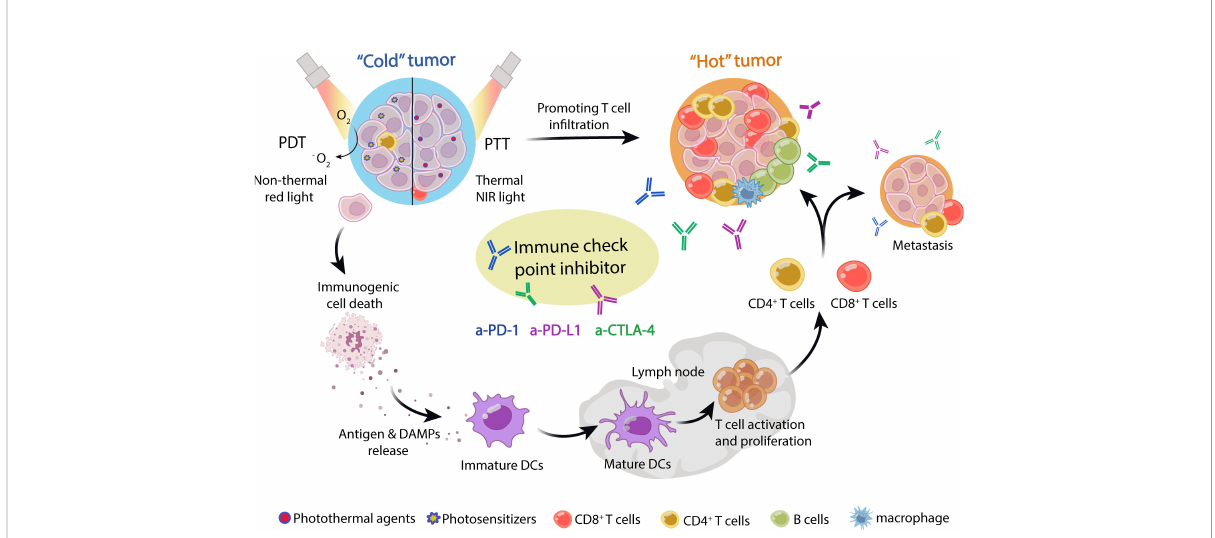
FIGURE 1 Schematic of phototherapy combined with ICB in cancer treatment. Nanoparticle-loaded photosensitizers or photothermal agents were ef fi ciently enriched in tumor tissue. Upon laser irradiation, photosensitizers or photothermal agents generate reactive oxygen species (ROS) and heat energy in PTT and PDT, respectively, which induces immunogenic cell death (ICD) of tumors. The dying tumor cells released tumor neoantigens and DAMPs, which stimulated DC maturation and activated T cells. Then, the tumor-speci fi c T cells were recruited into tumor niches and activated by ICIs, including anti-PD-1, anti-PD-L1, and anti-CTLA-4 antibody, which could effectively treat primary and metastatic tumors, as well as immune “ cold ” tumors. Thus, phototherapy can synergize with immune checkpoint blockade to treat